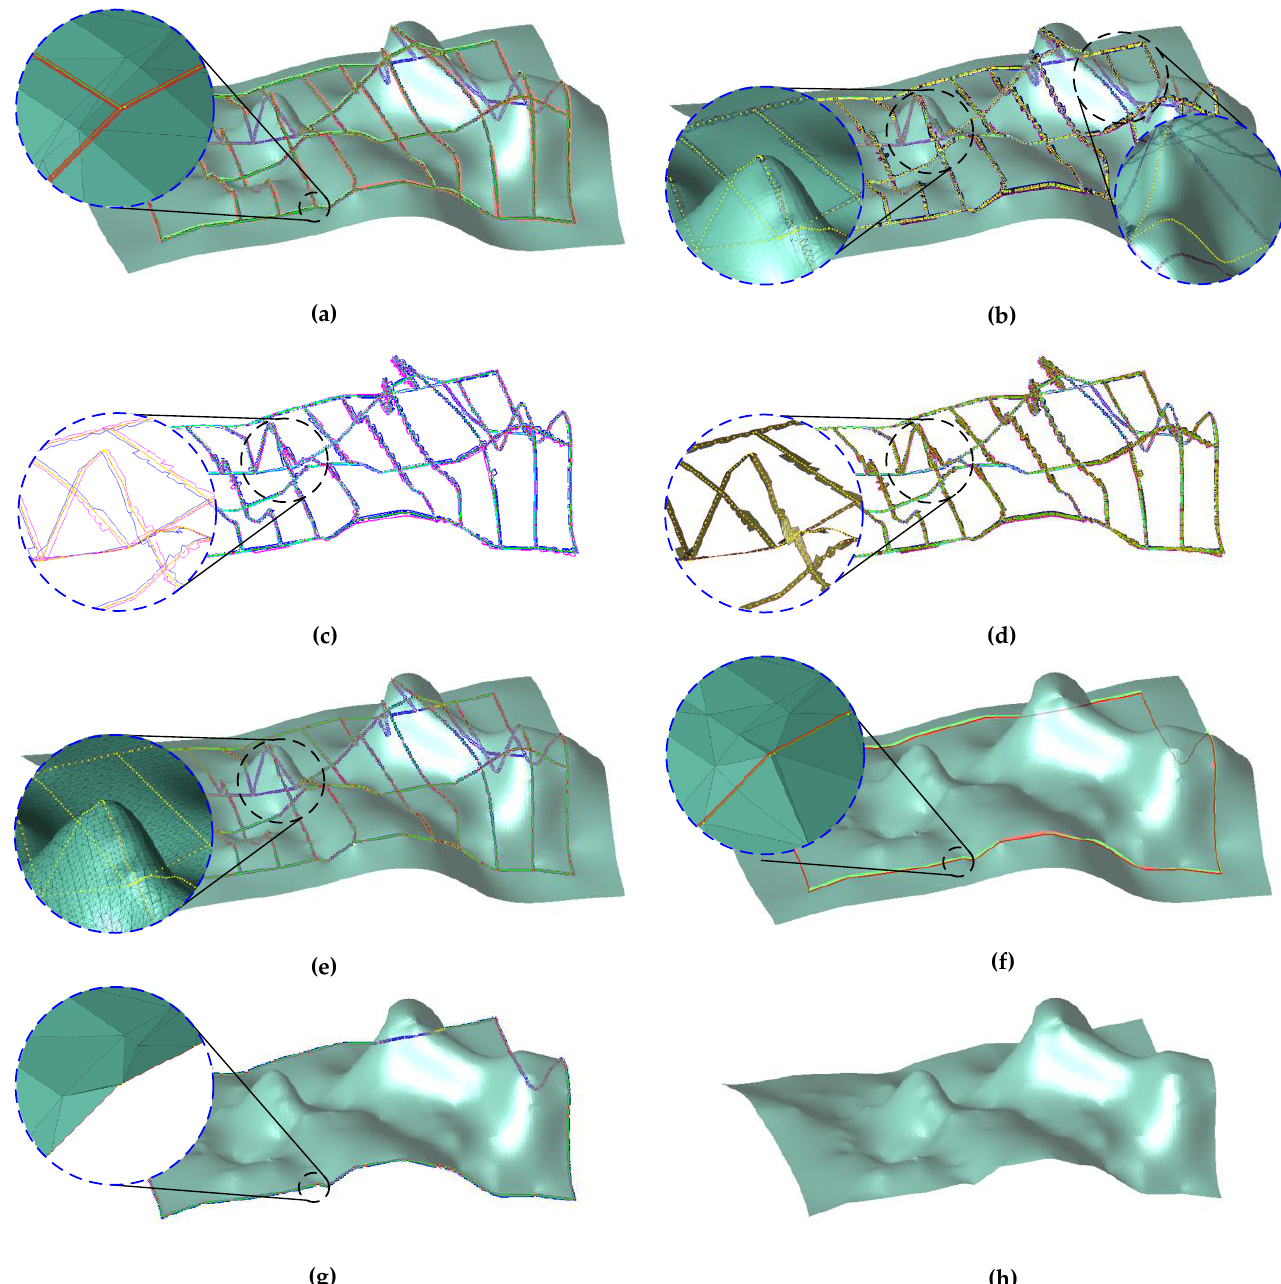
Figure 13. The third group test results of the snapping of feature polylines and the clipping of the model boundary. ( a ) shows constraint polylines and implicit modeling results. ( b ) shows the process of constraint polyline projection and mesh matching. ( c ) shows the matched mesh boundaries. ( d ) shows the re-meshing of the matching meshes. ( e ) shows the results of mesh merging and normal consistency. ( f ) shows the boundary constraint polylines and the model after normal consistency. ( g ) shows the result of mesh boundary clipping. ( h ) shows the orebody model after mesh processing.